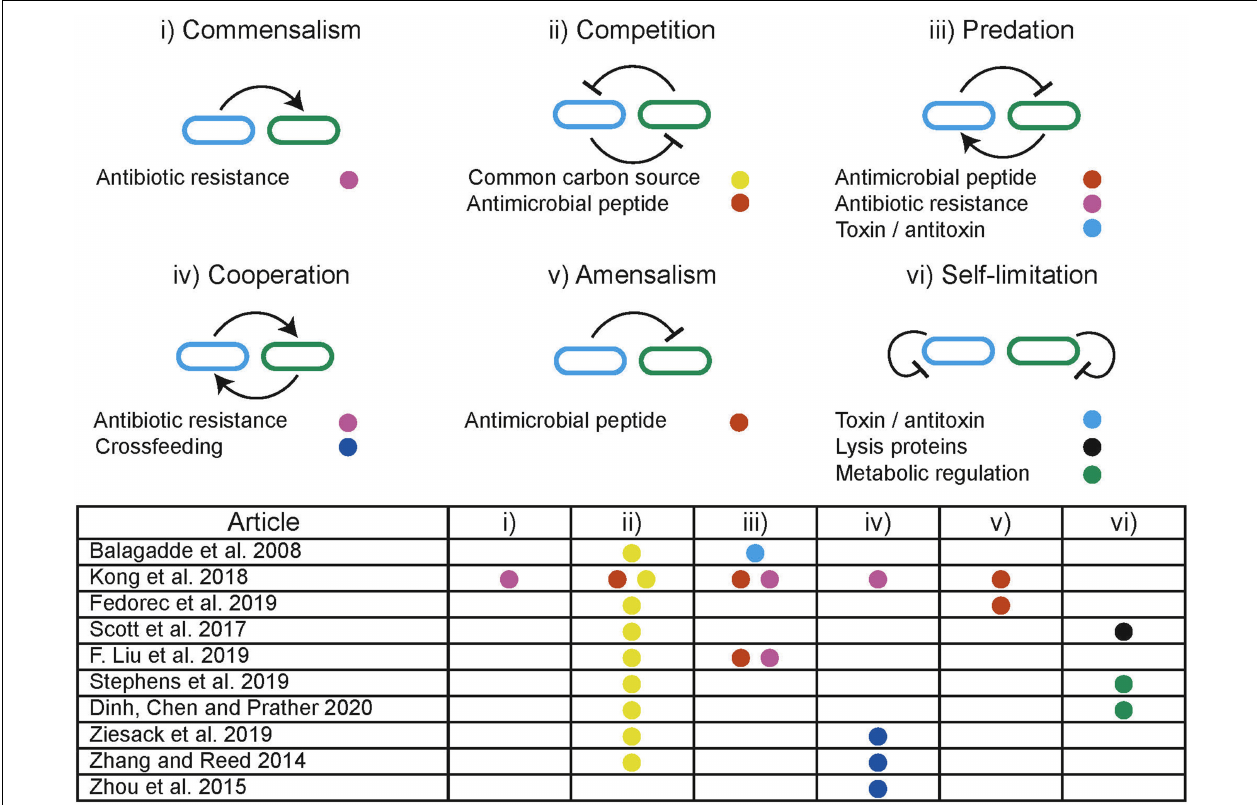
FIGURE 6 | Illustration of ecological interactions that can be used to dynamically manipulate resource allocation within co-cultures. Table summarizes the ecological interactions engineered in discussed studies where the colored dots refer to the methods used to implement the interaction.